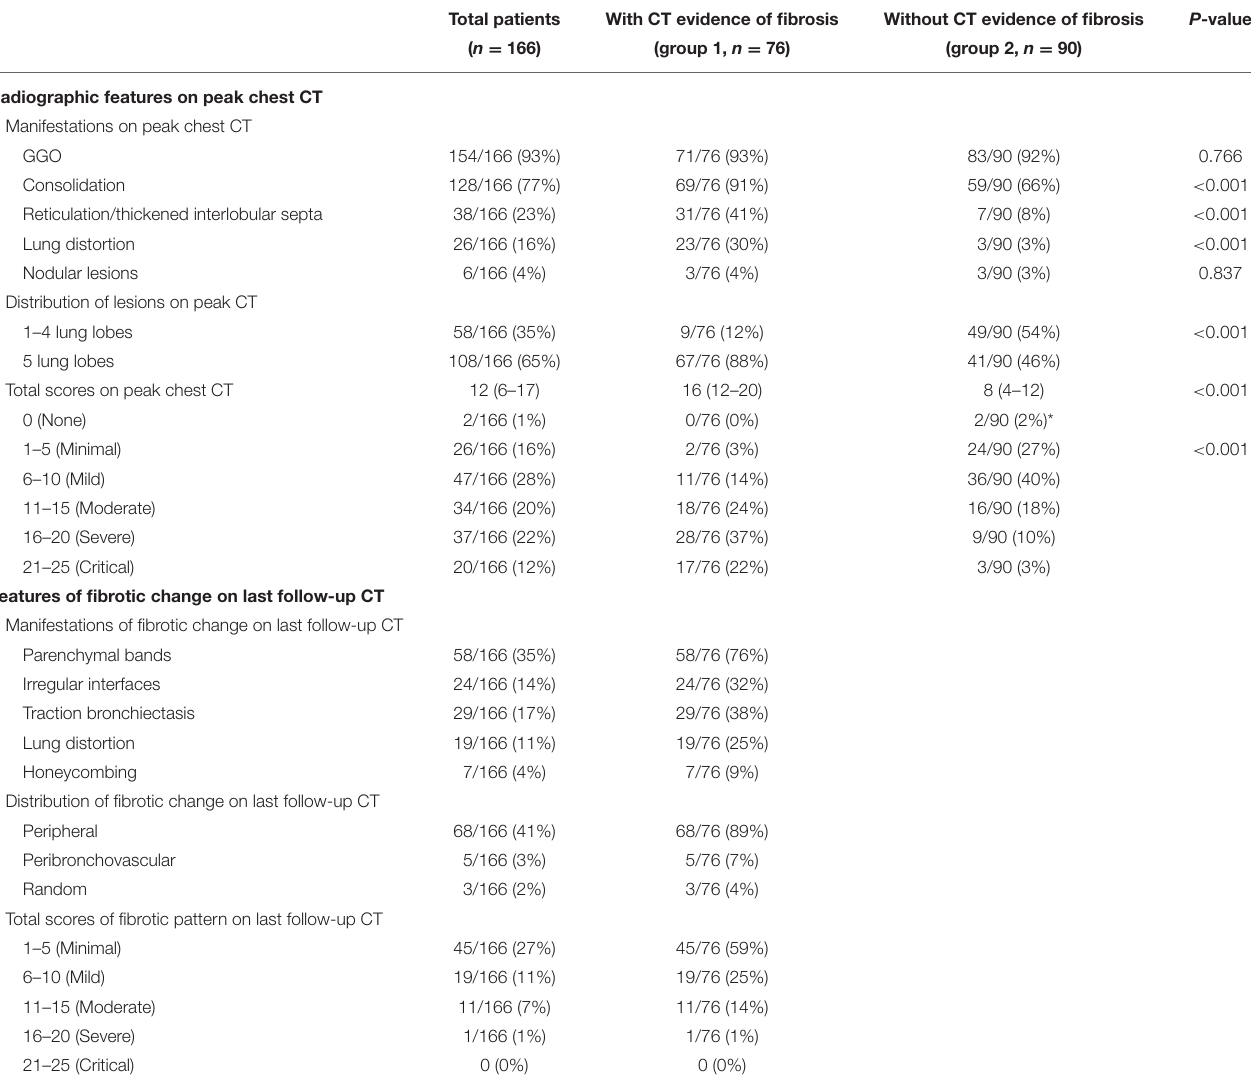
TABLE 4 | Radiographic findings on peak chest CT and features of fibrotic change on last follow-up CT in patients with